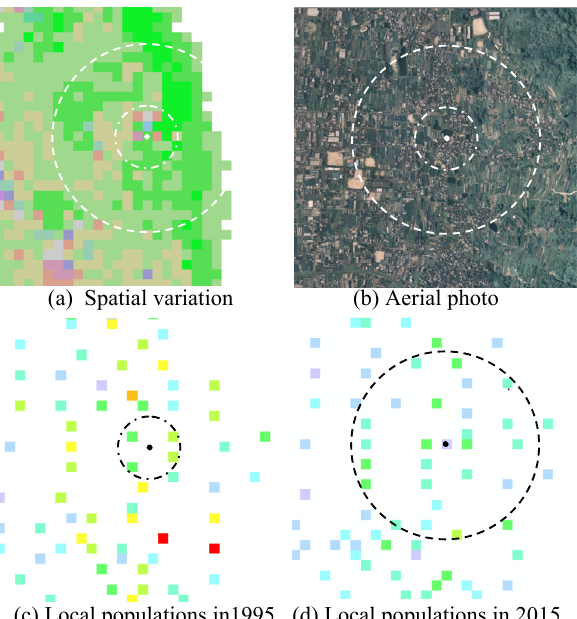
Figure 13 . Partial image of site E in Figure 10 along with aerial photograph and local population distributions. Dashed circle denotes ASP = 210 m in 1995, while dotted circle means ASP = 450 m in 2015.